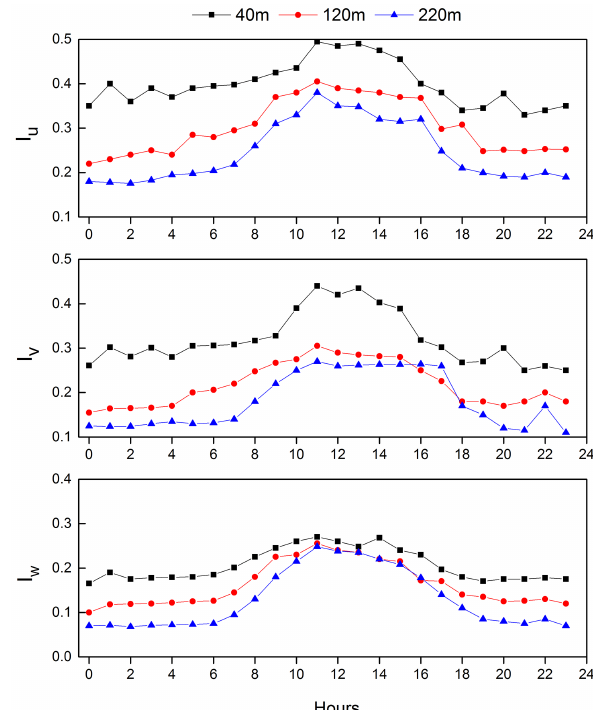
Figure 4. Averaged diurnal variation of three-dimensional compo- nents of turbulent intensity at different heights (longitudinal turbu- lent intensity I u , lateral turbulent intensity I v , vertical turbulent in- tensity I w